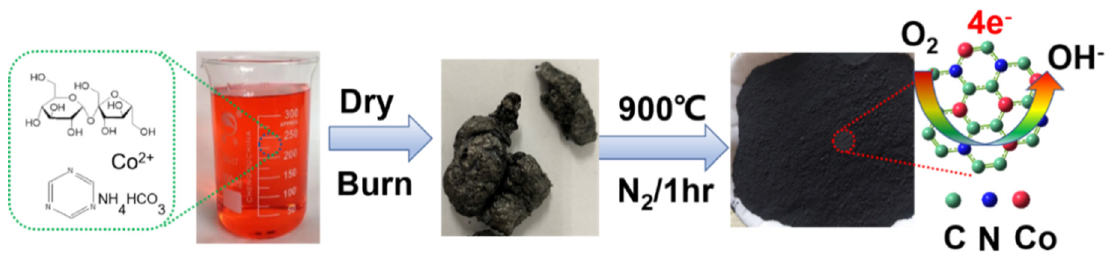
Figure 1. A schematic illustration of the preparation of the Co/N-C using the “Pharaoh’s snakes” reaction.